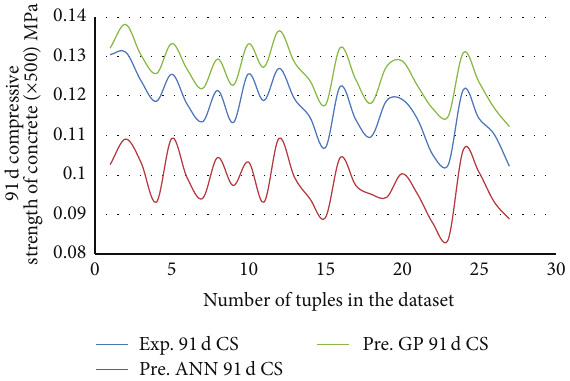
Figure 6: Comparison between actual and predicted values of 91 d compressive strength of concrete with FA.